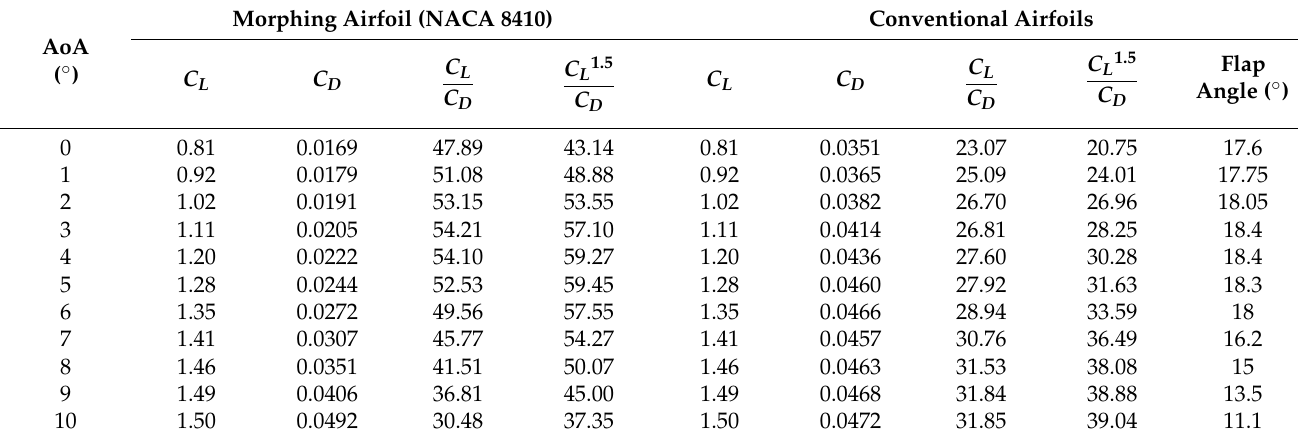
Table 4. Aerodynamic data of morphing (NACA 8410) and matching C L conventional airfoils.